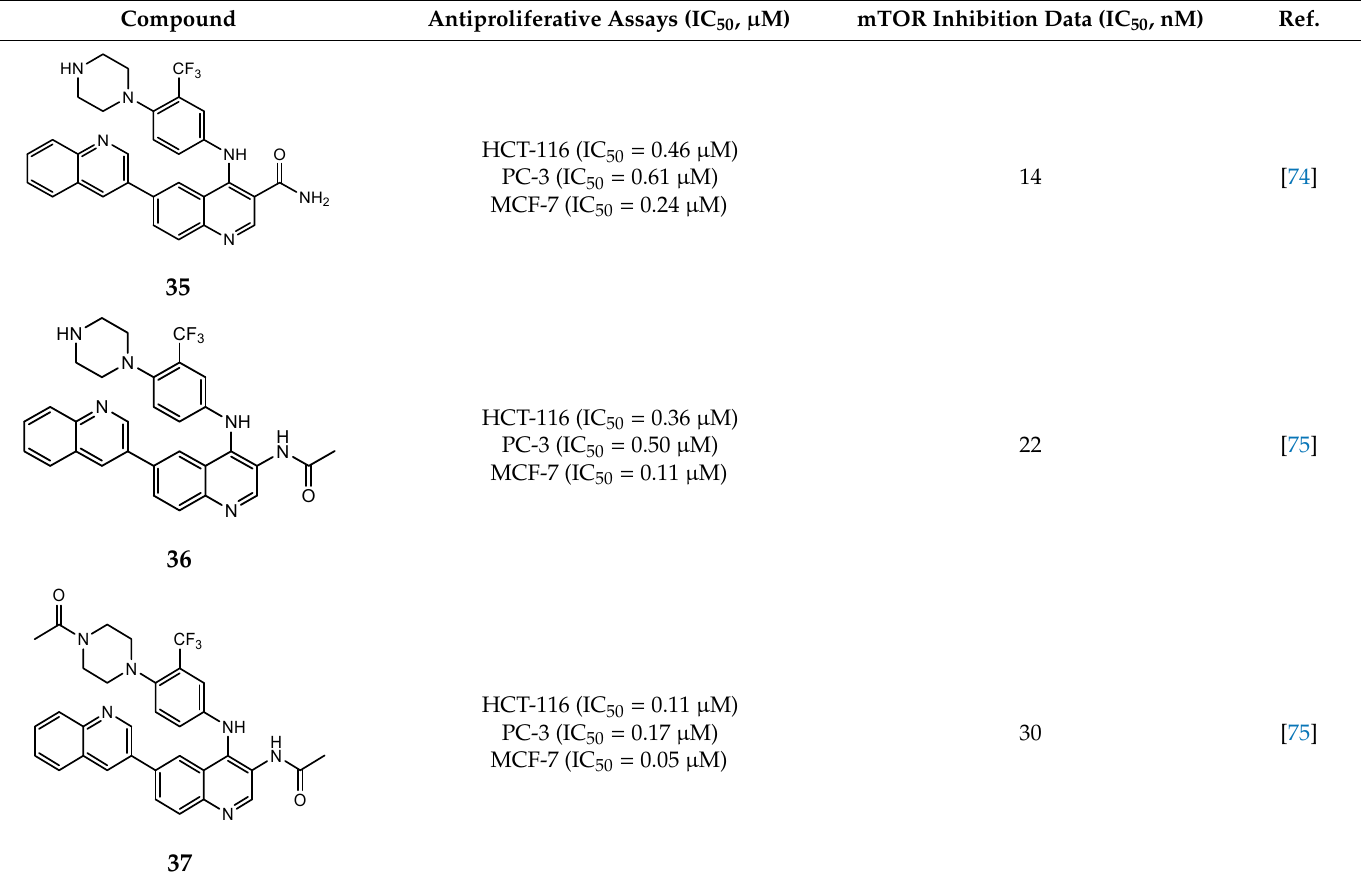
Table 3. Quinoline derivatives 35–37 with interesting activity on both mTORC1 and mTORC2.